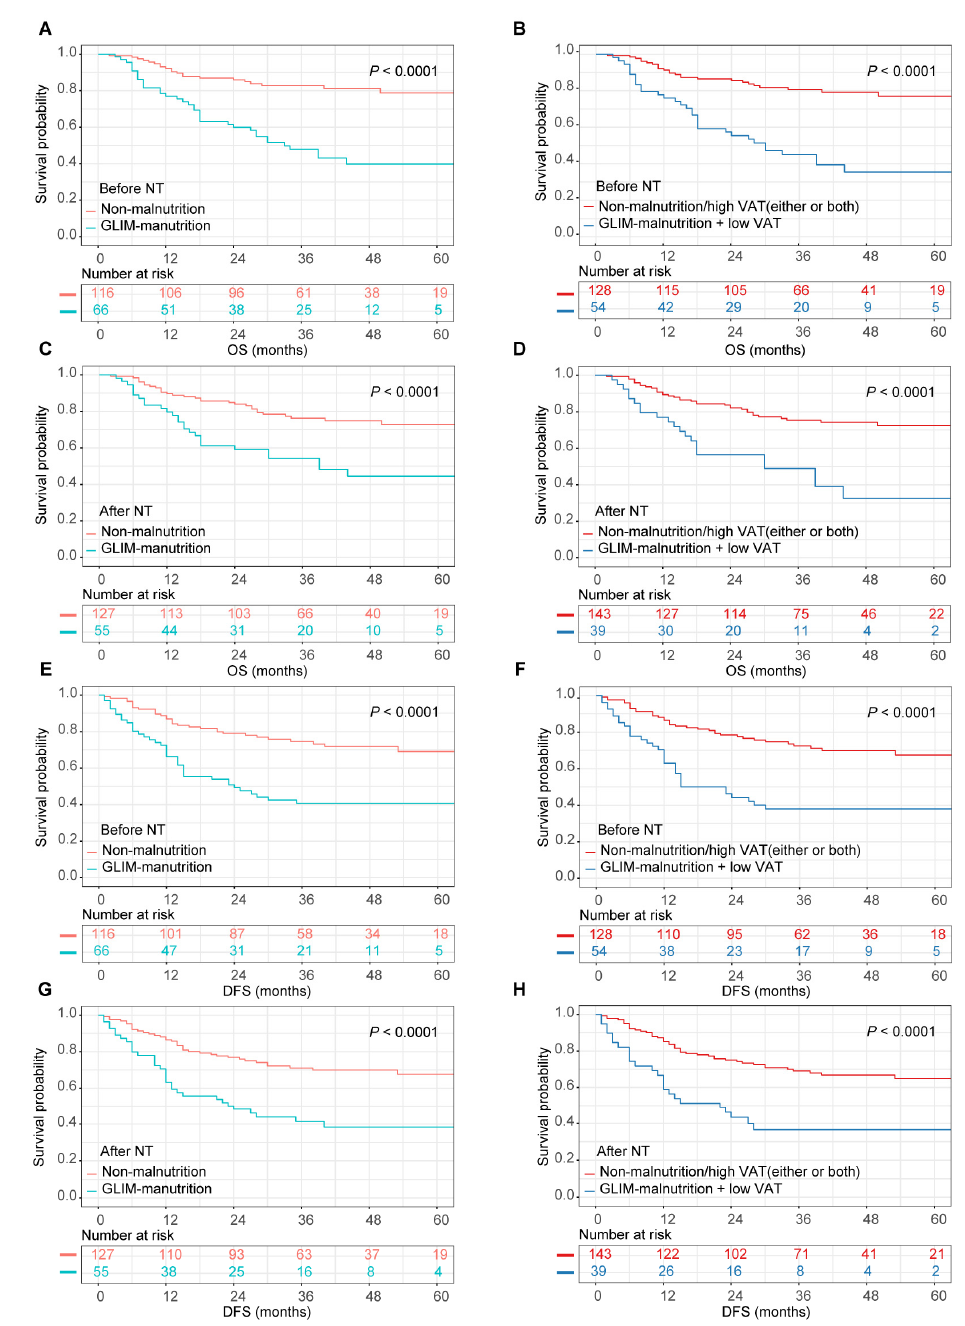
Figure 1. The associations between malnutrition diagnoses and long-term survival. GLIM, Global Leadership Initiative on Malnutrition; VAT, visceral adipose tissue; OS, overall survival; DFS, disease-free survival. For OS: ( A ) Kaplan–Meier curves stratified by GLIM-malnutrition before NT. ( B ) Kaplan–Meier curves stratified by GLIM-malnutrition plus low VAT before NT. ( C ) Kaplan–Meier curves stratified by GLIM-malnutrition after NT. ( D ) Kaplan–Meier curves stratified by GLIM-malnutrition plus low VAT after NT. For DFS: ( E ) Kaplan–Meier curves stratified by GLIM-malnutrition before NT. ( F ) Kaplan–Meier curves stratified by GLIM-malnutrition plus low VAT before NT. ( G ) Kaplan–Meier curves stratified by GLIM-malnutrition after NT. ( H ) Kaplan–Meier curves stratified by GLIM- malnutrition plus low VAT after